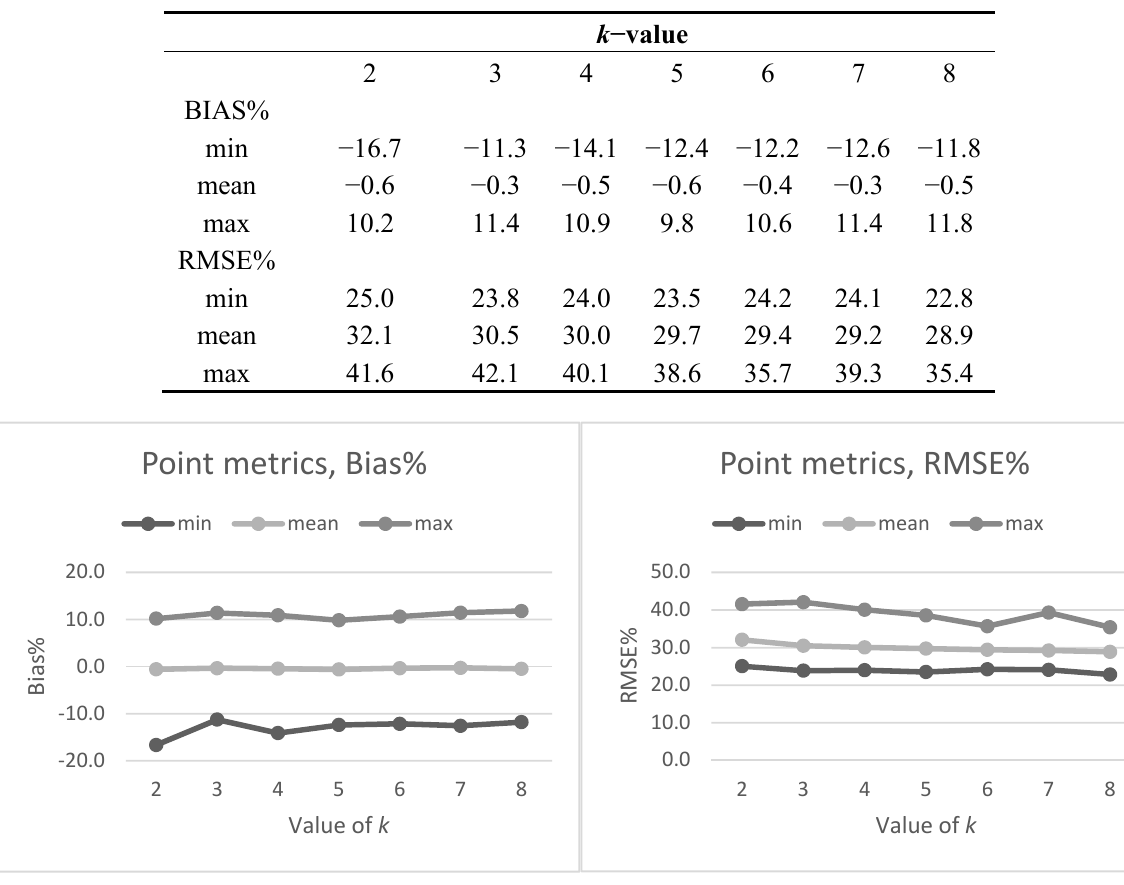
Table A1. The effect of k -value to the estimated bias% and RMSE% of totalB using point metrics as predictor variables.